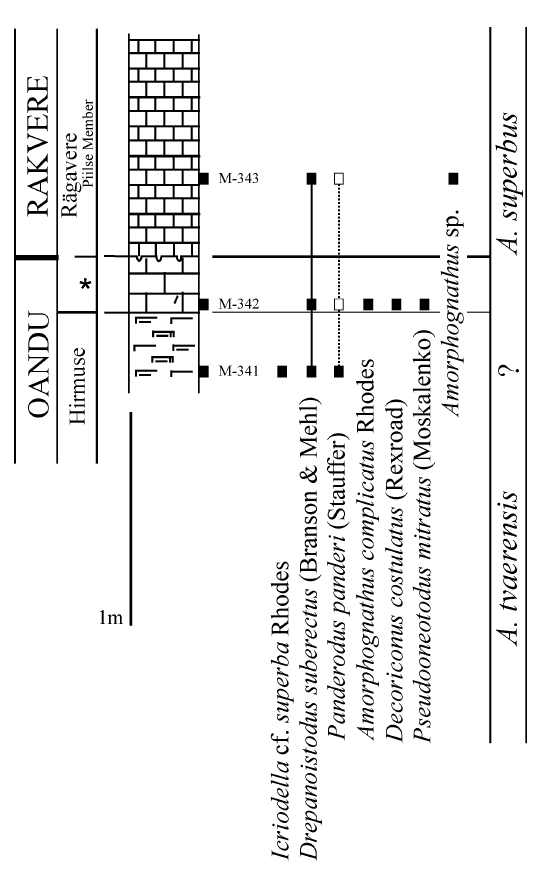
Fig. 7. Distribution of conodonts in the Rakvere section. For the explanation and legend refer to Fig. 3. Just to the right of the log sample numbers are indicated instead of